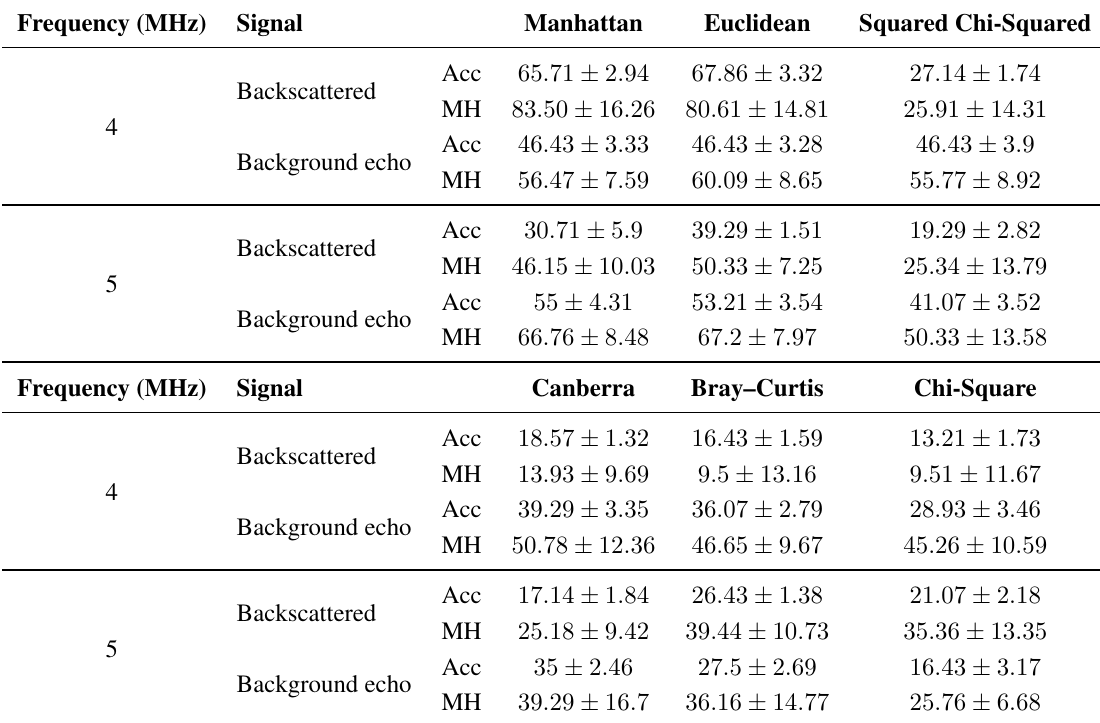
Table 13. Accuracy rates and harmonic mean for the 4- and 5-MHz frequency signals at 650 and 950 ◦ C.